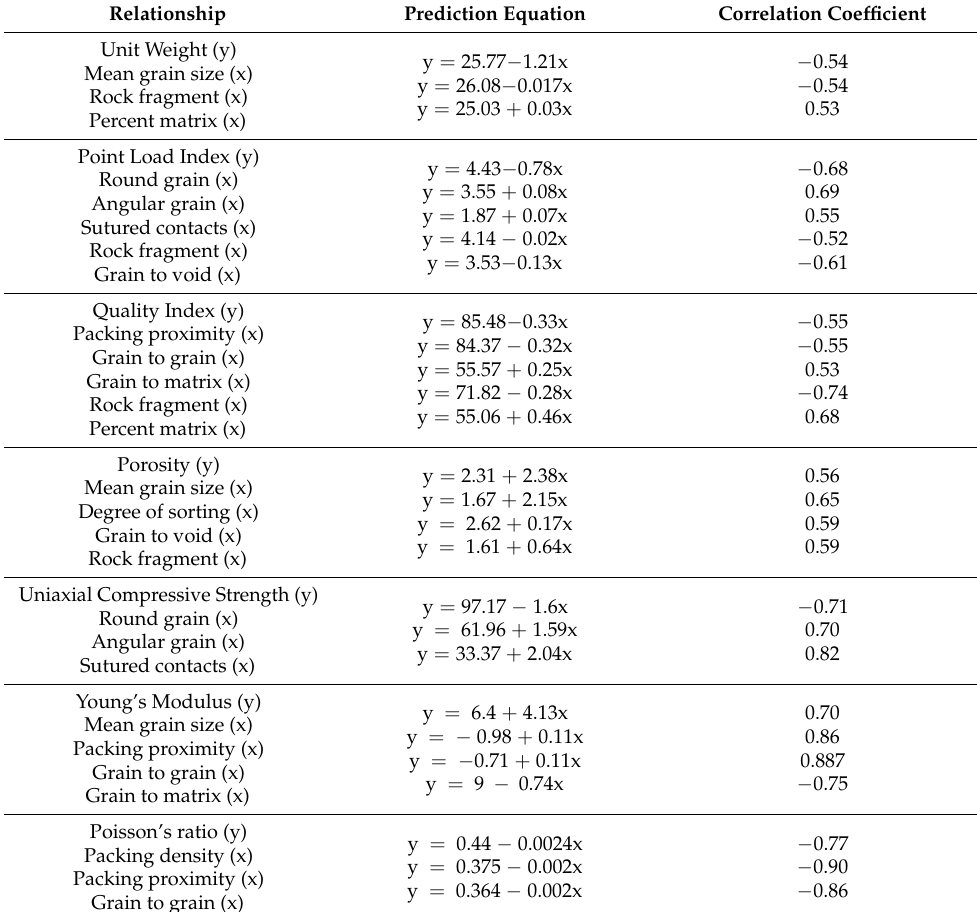
Table 13. Relationship between some aspects of rock texture [60] (unit weight in KN/m 3 , point load index in MPa, quality index in %, porosity in %, uniaxial compressive strength in MPa, Young’s modulus in (GPa), mean grain size in mm; all petrographic characteristics given as independent variables are in percent).